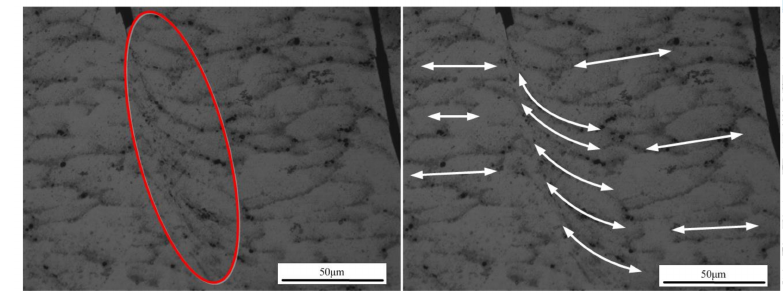
Figure 14. Shearing slip.